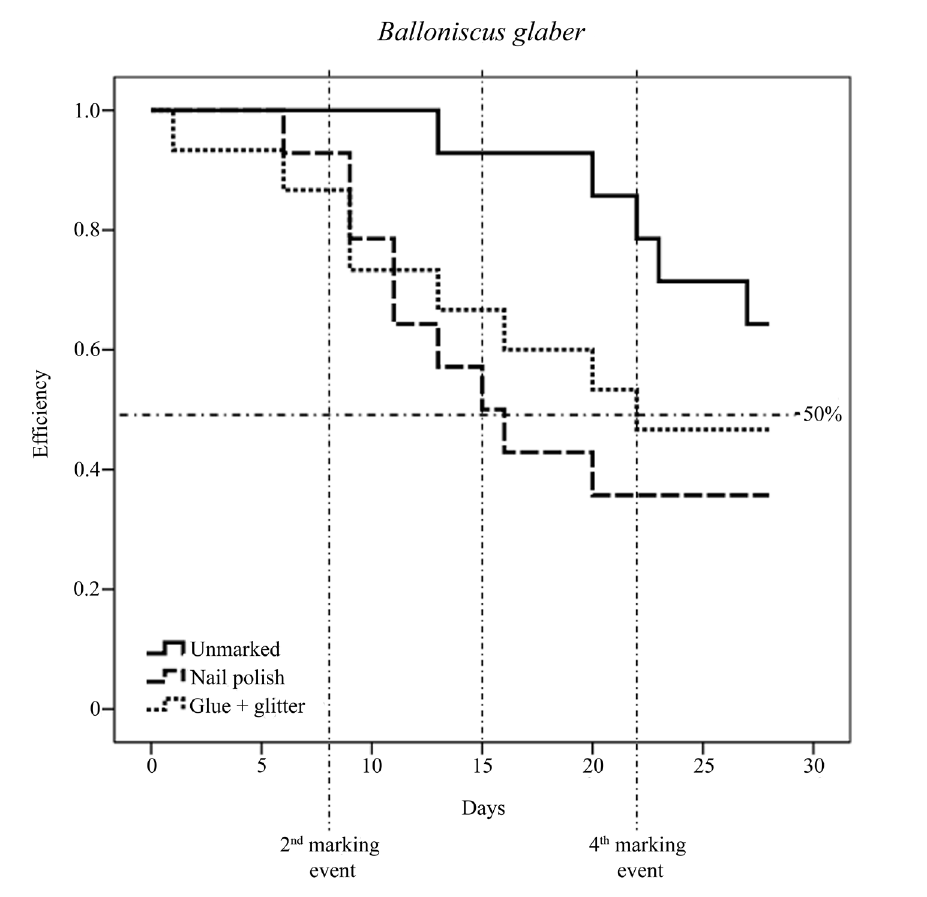
Figure 3. Kaplan-Meier curves for the external marking efficiency (durability) of the two materials tested on Balloniscus glaber for 28 days of observation. Vertical dotted lines indicate the second, third and the forth event of external marking (8 th , 15 th and 22 th days, respectively). Horizontal dotted line delimits the 50% of remaining marked